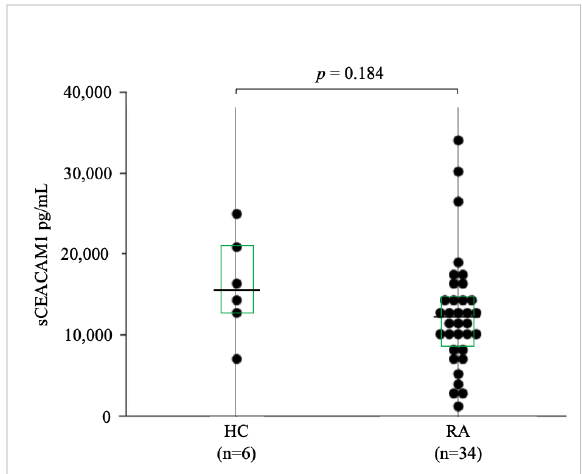
FIGURE 5 Serum levels of sCEACAM1 in RA. The comparison of serum levels of sCEACAM1 between HC (n=6) and RA patients (n=34). There were no signi fi cant differences between HC and RA patients. Statistical signi fi cance was determined by the Mann – Whitney U test. Horizontal bars and squares indicate median and IQR, respectively. sCEACAM1, soluble CEACAM1; HC, healthy controls; RA, rheumatoid arthritis; IQR, interquartile